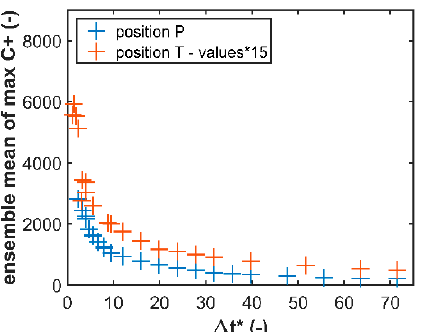
Figure 10. Dependence of the mean maximum concentration on the release duration utilizing puff scaling (note: the statement values*15 means that the values were multiplied by 15 to be able to show the results of both positions in one figure).